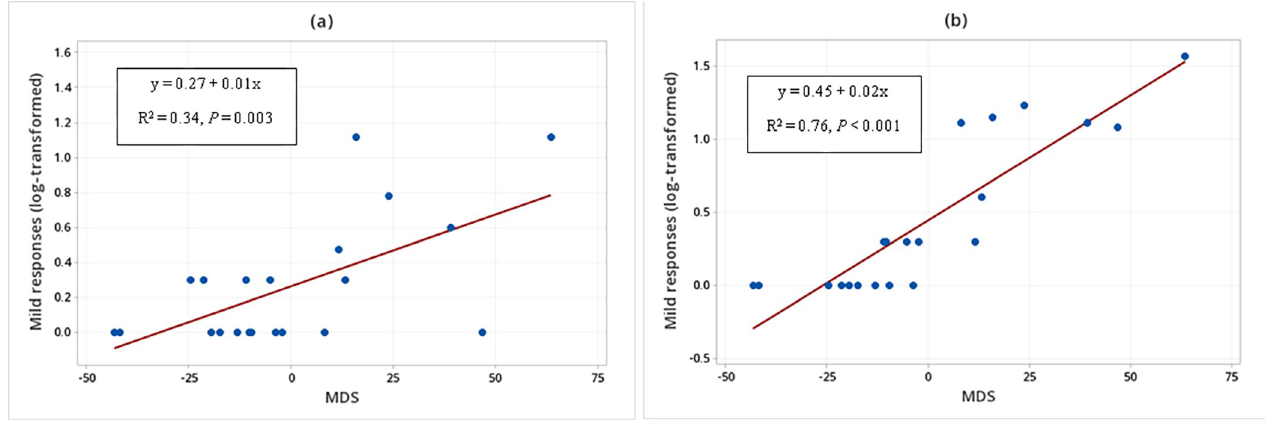
Fig 8. Relationship between the sender’s social rank (MDS) and the occurrence of non-aggressive responses (log-transformed). (a) Occurrence of non- aggressive responses to unimodal signals. (b) Occurrence of non-aggressive responses to multimodal signals, when white-lipped peccaries (N = 21) were displaying threatening